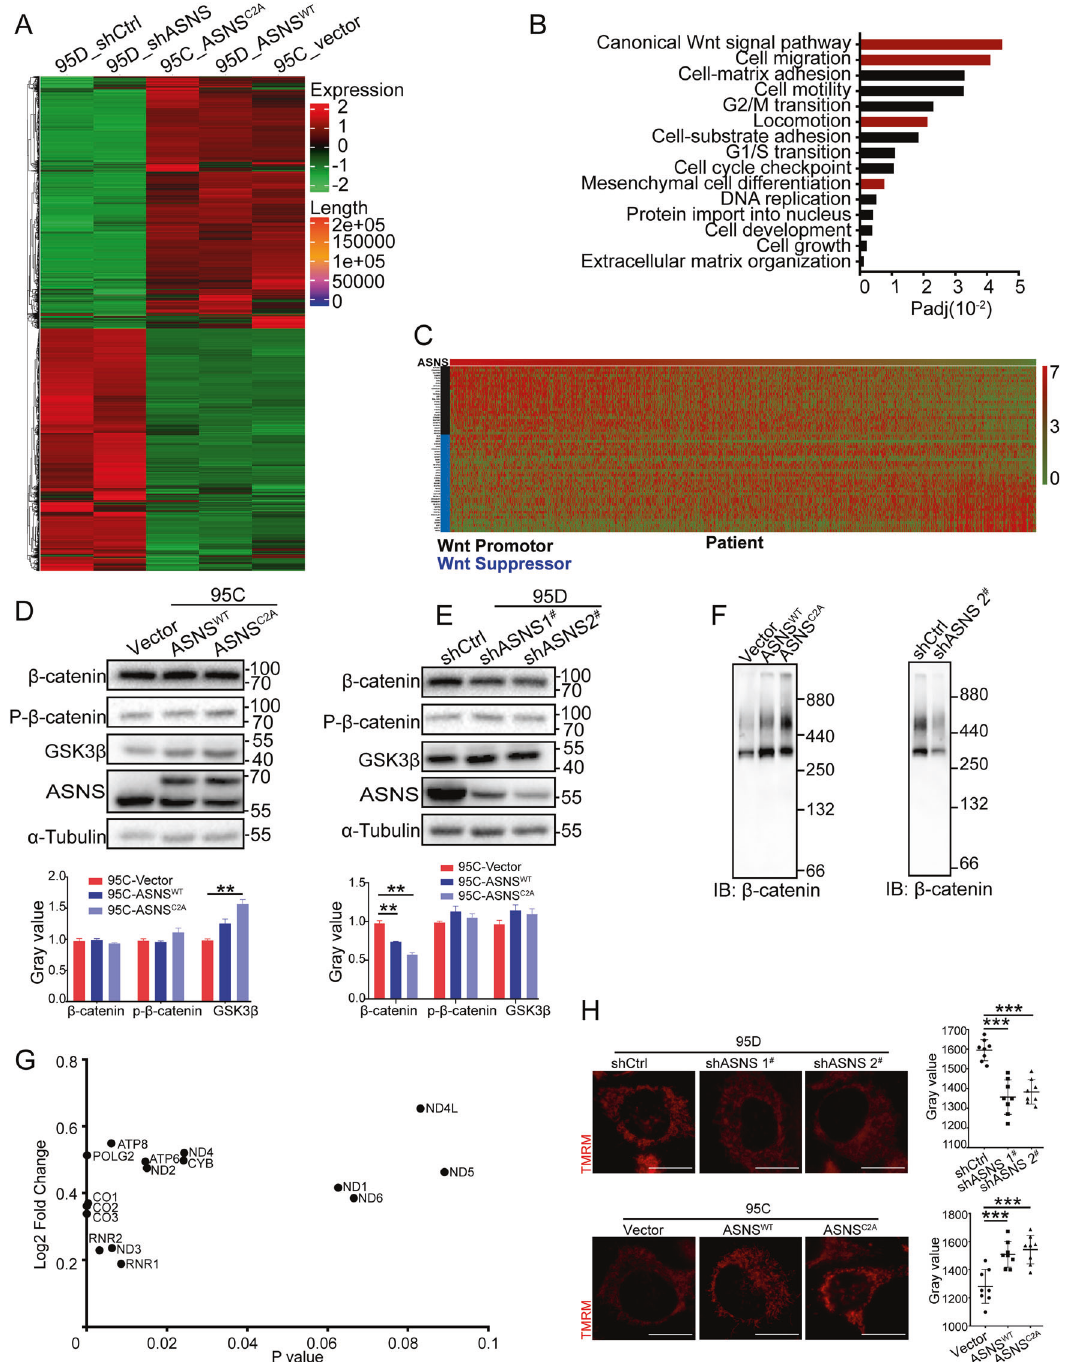
Fig. 3 ASNS stabilizes the β -catenin complex and upregulates mitochondrial potential. The whole-cell RNA was extracted and put into RNA sequencing ( A ). Some pathways were enriched in the differential gene expression pool ( B ). C RNA sequencing data was collected from the TCGA, then ranked Wnt pathway-related genes by gradient ASNS mRNA level from higher to lower. β -catenin, an important secondary messenger was tested in ASNS overexpressed ( D ) and knockdown ( E ) cell lines. F The stability of β -catenin complexes was detected by blue native page in overexpressed and knockdown cell lines. G 11 mitochondrial coding mRNAs and POLG2 mRNA were found in differential expression gene pools. H TMRM was a special probe to detect mitochondrial potential. The mitochondrial potential was detected in overexpressed and knockdown cell lines; the white bar was 20 μ m. Error bars were expressed as mean ± S.D. P < 0.05 is signi fi cant statistic difference, * p < 0.05, ** p < 0.01, *** p < 0.001. Representative images from three independent experiments are RNA sequencing data were collected from the TCGA database was extracted for RNA sequencing (Fig. 3A). In the differential gene (https://xenabrowser.net/datapages/). Wnt pathway-related genes expression pool, many genes were enriched in the canonical Wnt were ranked by gradient ASNS mRNA level from higher to lower, signal pathway (Fig. 3B), which was a conserved pathway to promote higher ASNS mRNA level was positively correlated with the level of cell metastasis, survival, and proliferation. Furthermore, a lung-cancer